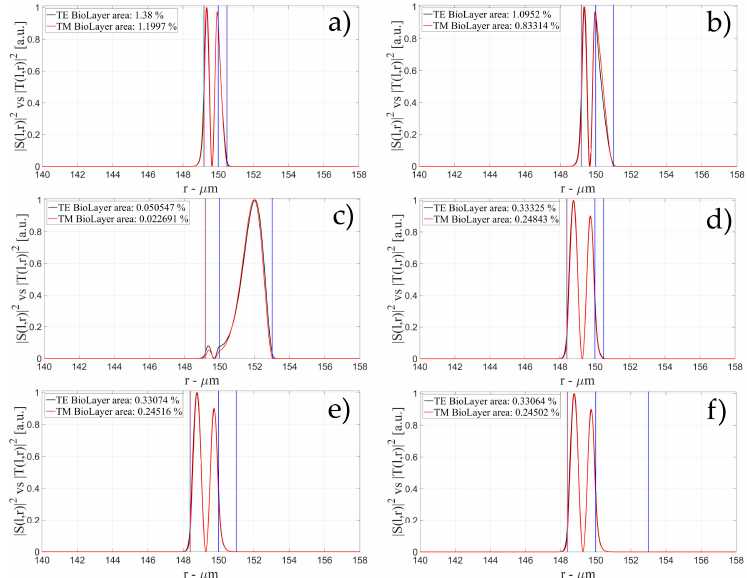
Figure 12. Electric field distribution of WGMs along the radial direction for TE (| S ( l,r ) | 2 ) and TM (| T ( l,r ) | 2 ) modes for the 2nd radial order: ( a ) for a wall of about 500 nm and a polymer thickness of about 800 nm; ( b ) for a wall of about 1 μ m and a polymer thickness of about 800 nm and ( c ) for a wall of about 3 μ m and a polymer thickness of about 800 nm; ( d ) for a wall of about 500 nm and a polymer thickness of about 1600 nm; ( e ) for a wall of about 1 μ m and a polymer thickness of about 1600 nm and ( f ) for a wall of about 3 μ m and a polymer thickness of about 1600 nm. Legends show the fraction of | S ( l,r ) | 2 and | T ( l,r ) | 2 inside the biological layer.